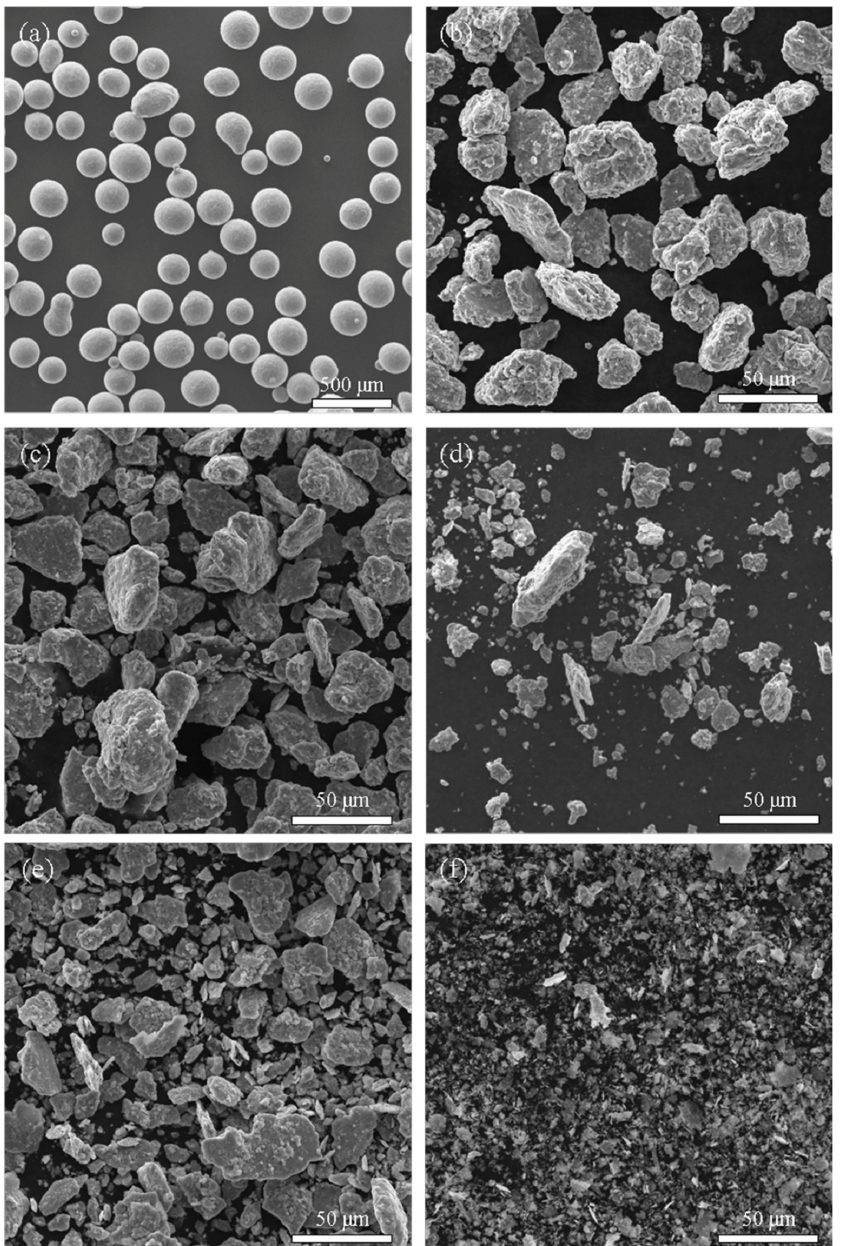
Figure 1. Surface morphologies of TiAl powder: ( a ) primary powder, ( b ) ball-milled powder at 200 r/min for 15 h (particle size = 29 μ m), ( c ) ball-milled powder at 250 r/min for 15 h (particle size = 26 μ m), ( d ) ball-milled powder at 250 r/min for 20 h (particle size = 17 μ m), ( e ) ball-milled powder at 250 r/min for 15 h (particle size = 15 μ m), ( f ) ball-milled powder at 300 r/min for 25 h (particle size = 5 µ m). ( b – d ) dry-milled, ( e , f )